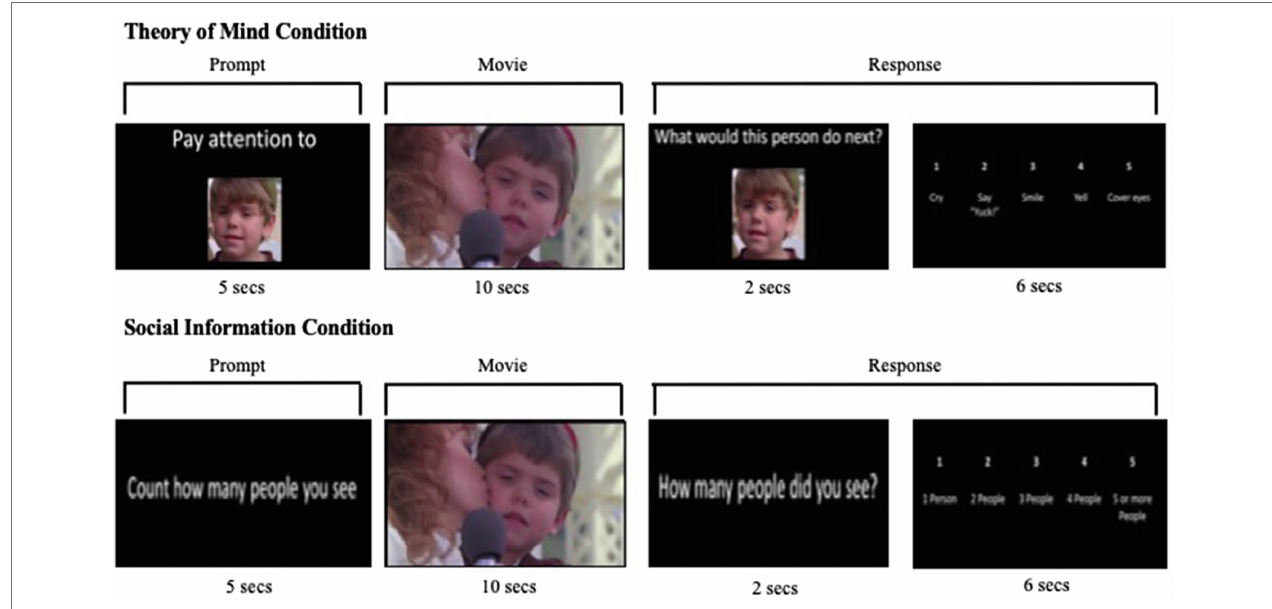
FIGURE 1 | Movie Mentalizing